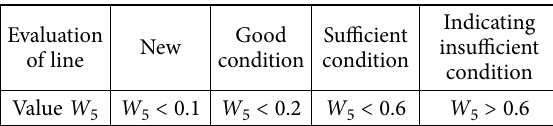
Table 2. Quality qualifications of track